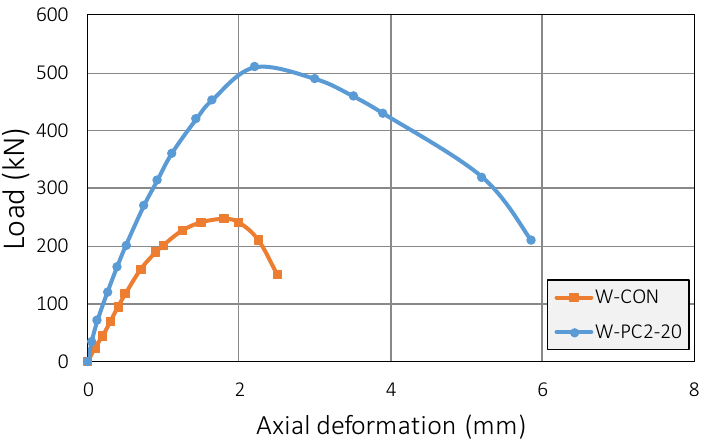
Figure 14. Experimental responses (Control and PC2 walls without wire mesh).